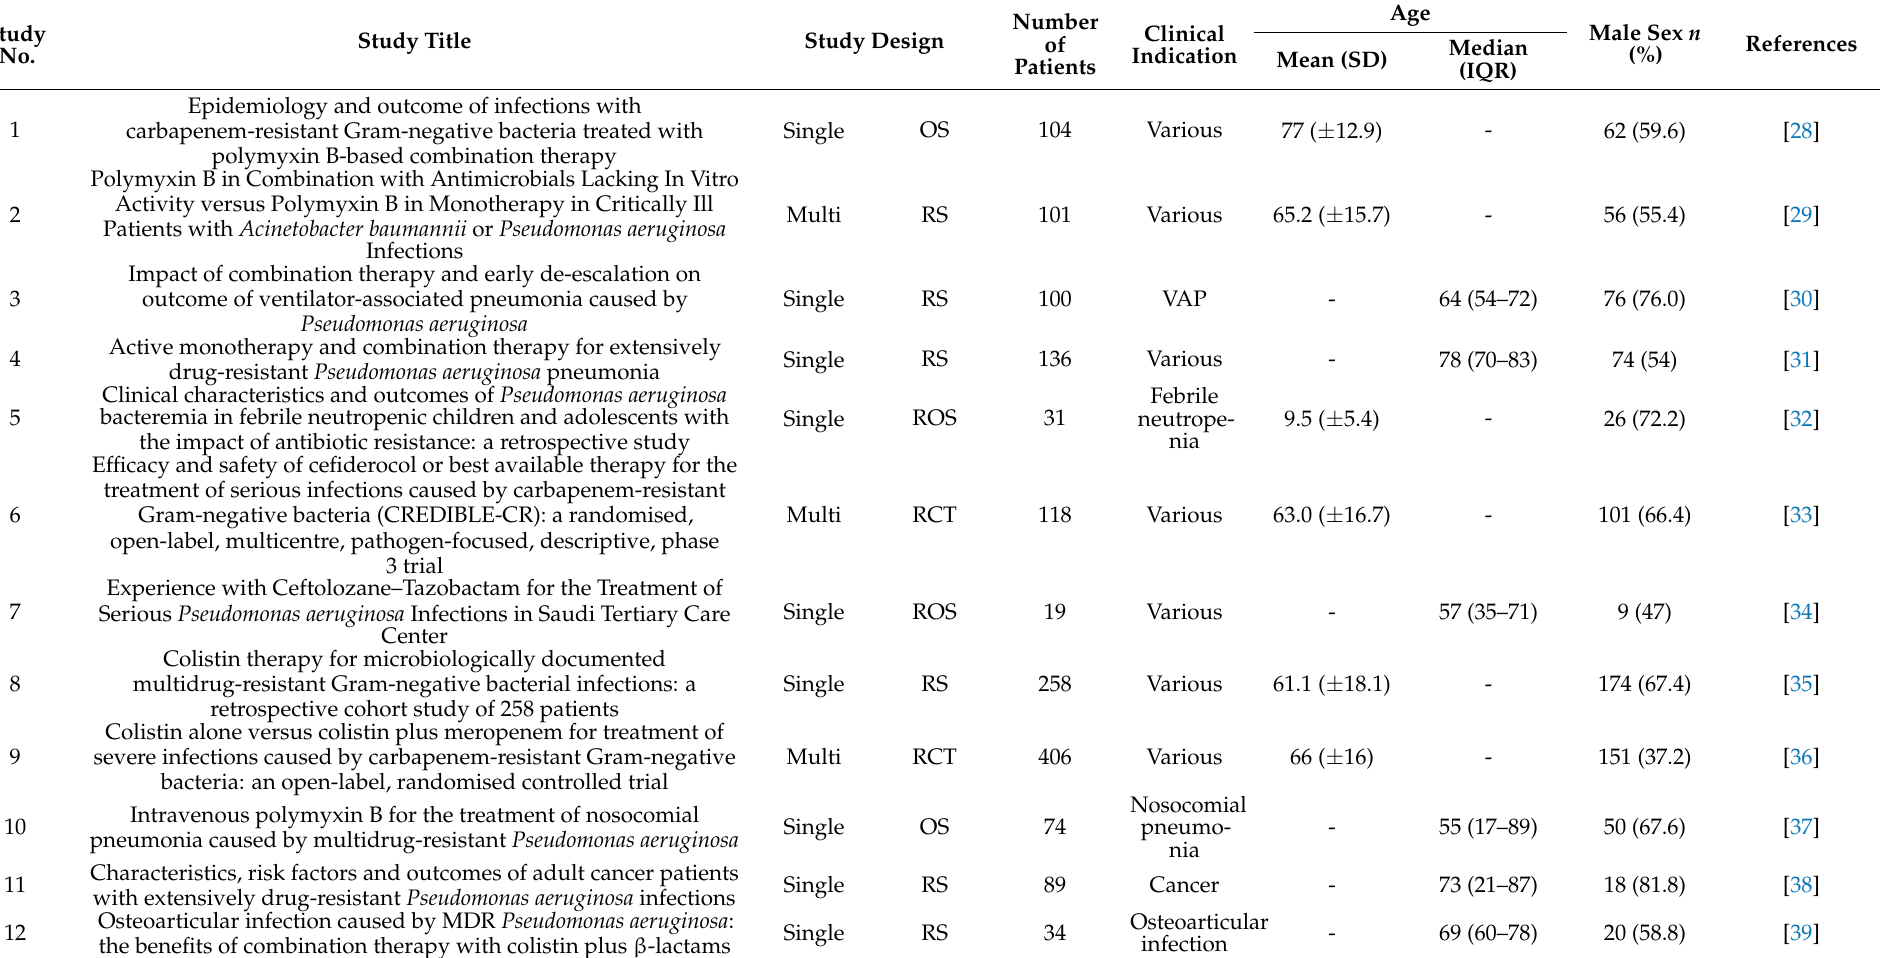
Table 2. Study characteristics included in